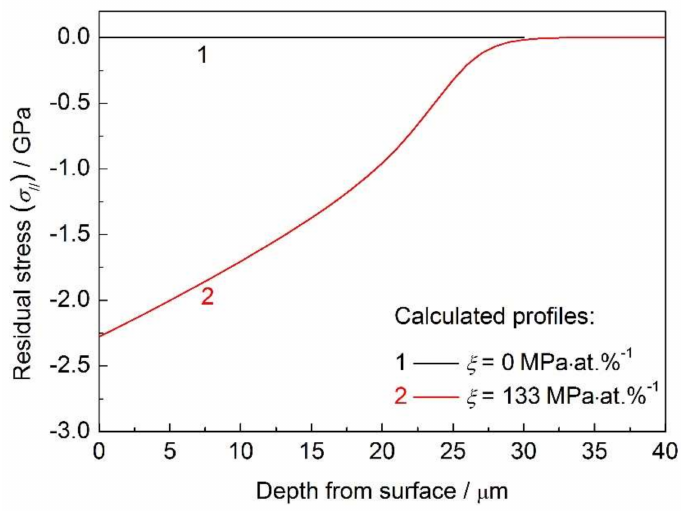
Figure 4. Calculated residual stress-depth profiles of AISI 316L carburized at 470 ◦ C for 30 h using different value of ξ